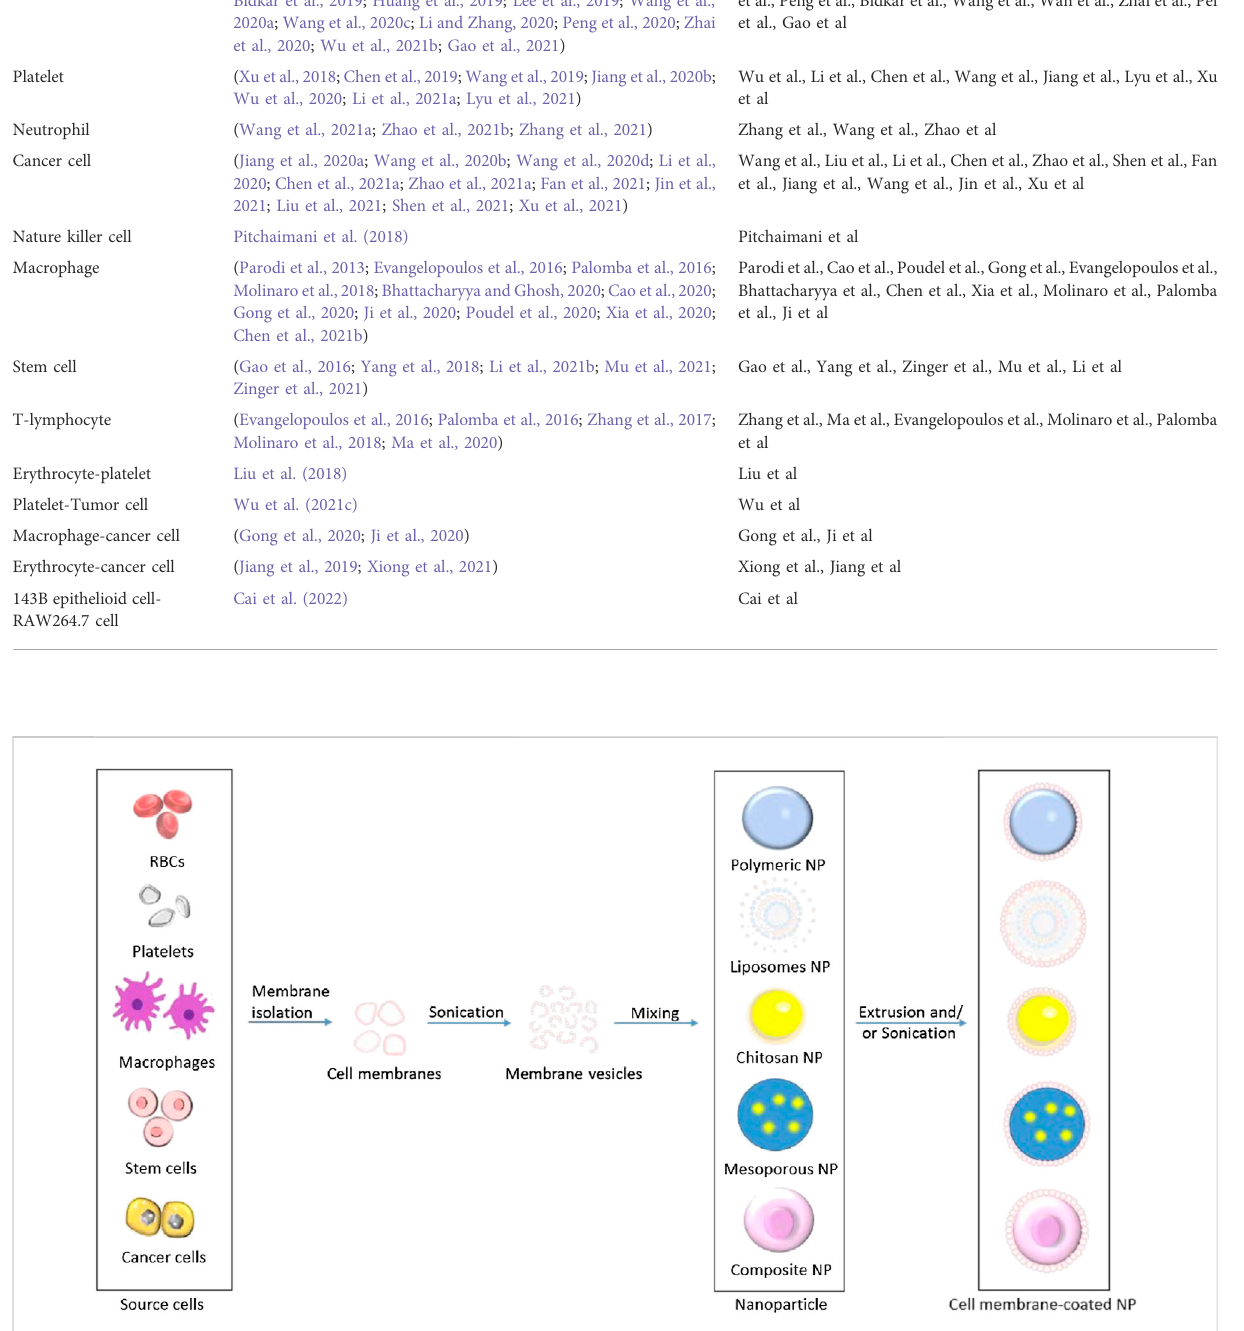
Frontiers in Bioengineering and